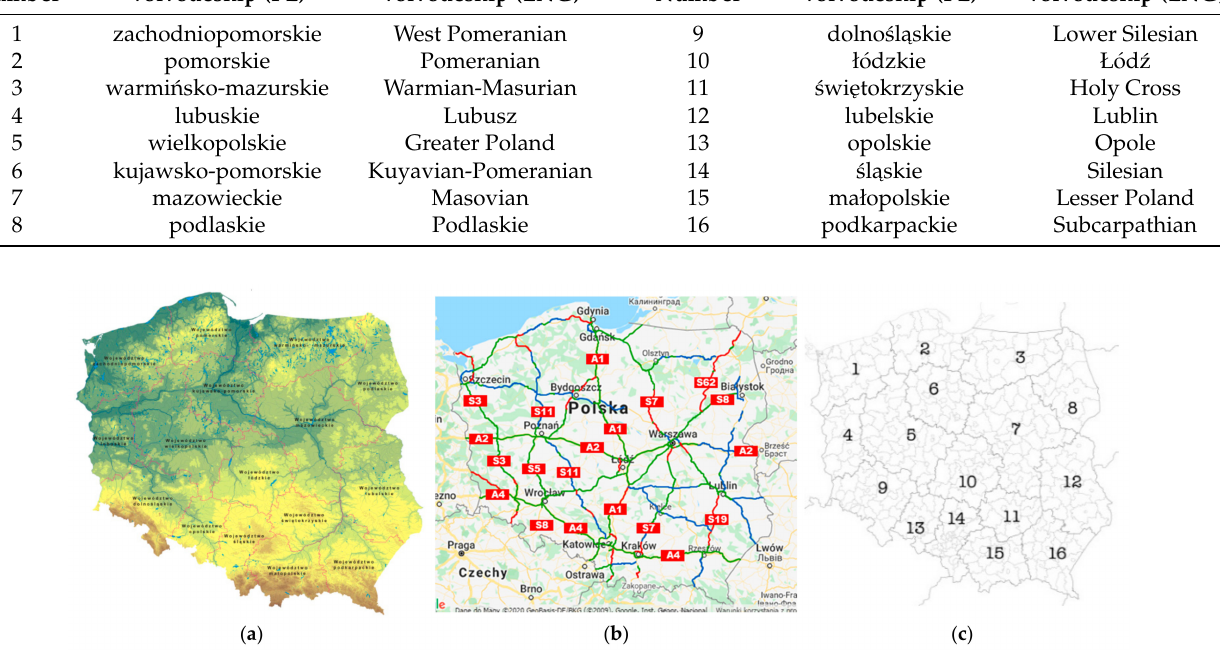
Figure 4. ( a ) The hypsometric and administrative map of Poland (source: https://pl.wikipedia.org/ wiki/) (accessed on 17 November 2021); ( b ) main road routes in Poland (source: